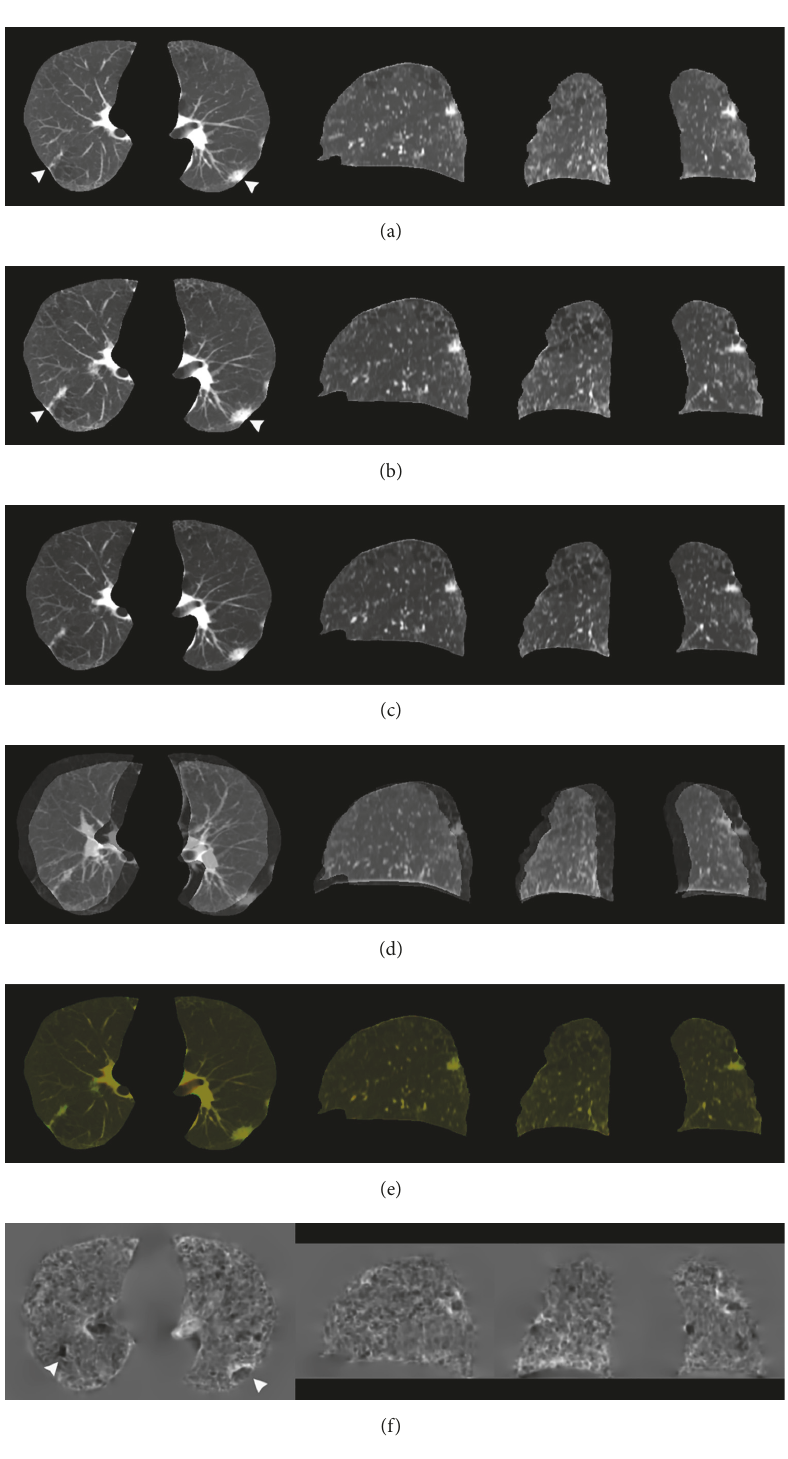
Figure1:Sampleoutputofdeformableimageregistration.Thecolumnsfromlefttorightaretheaxial,sagittal,andcoronalplanes,respectively. The white arrows indicate the left lung lesion and the right lung latent lesion. (a) Moving images (previous images) in the axial plane. The lengths of the long and short diameters of the left lung lesion are 33 and 20 mm, respectively. (b) Fixed images (current images, interval of 4 months 6 days). In the axial plane, the long and short diameters of the left lung lesion are 40 and 18.5 mm, respectively. (c) Warped moving images. The long and short diameters of the left lung lesion are 33 and 20 mm, respectively. (d) Overlapping of moving and fixed images (showed misregistration). The position of the lung surface shows a clear difference between moving and fixed volumes. (e) Overlapping of the warped moving and fixed images (well-matched). Red indicates the warped moving image and green indicates the fixed image. (f) Log-Jacobian image of the deformation